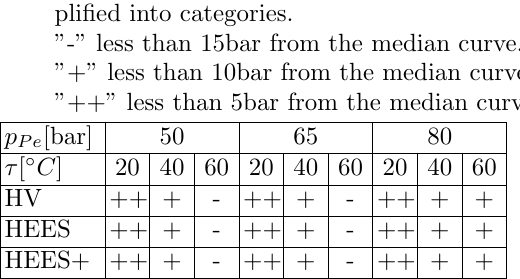
Table 6: Model accuracy. Accuracy is based on the av- erage distance to the median curve and sim- plified into